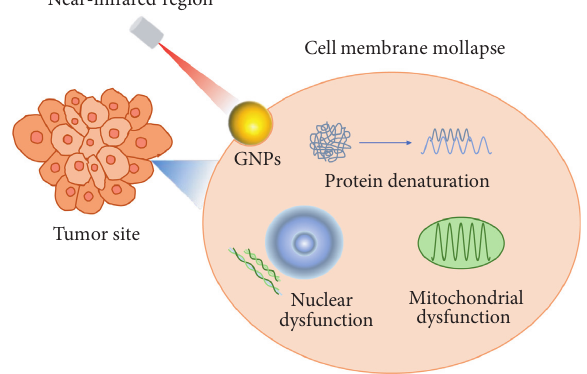
Figure 6: Apoptosis of tumor cells induced by